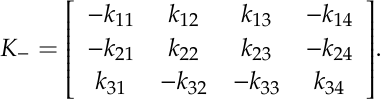
between vectors as is shown in Figure 9. By changing the sign of appropriate observer gains after 180 degrees, by multiplying gains k 11 and k 14 by -1 for negative rotation speed values, restores angles